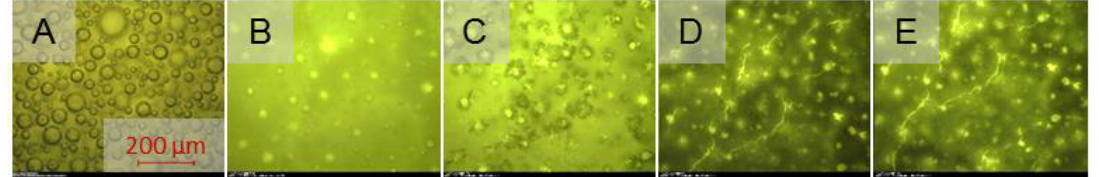
Figure 6. Drying of a polysorbate 80 foam with 40% MD at different stages of the drying process: ( A ) liquid, ( B ) frozen, ( C ) early drying, ( D ) mid drying, ( E ) final drying. The scale bar in ( A ) can also be applied to ( B ) – ( E ).